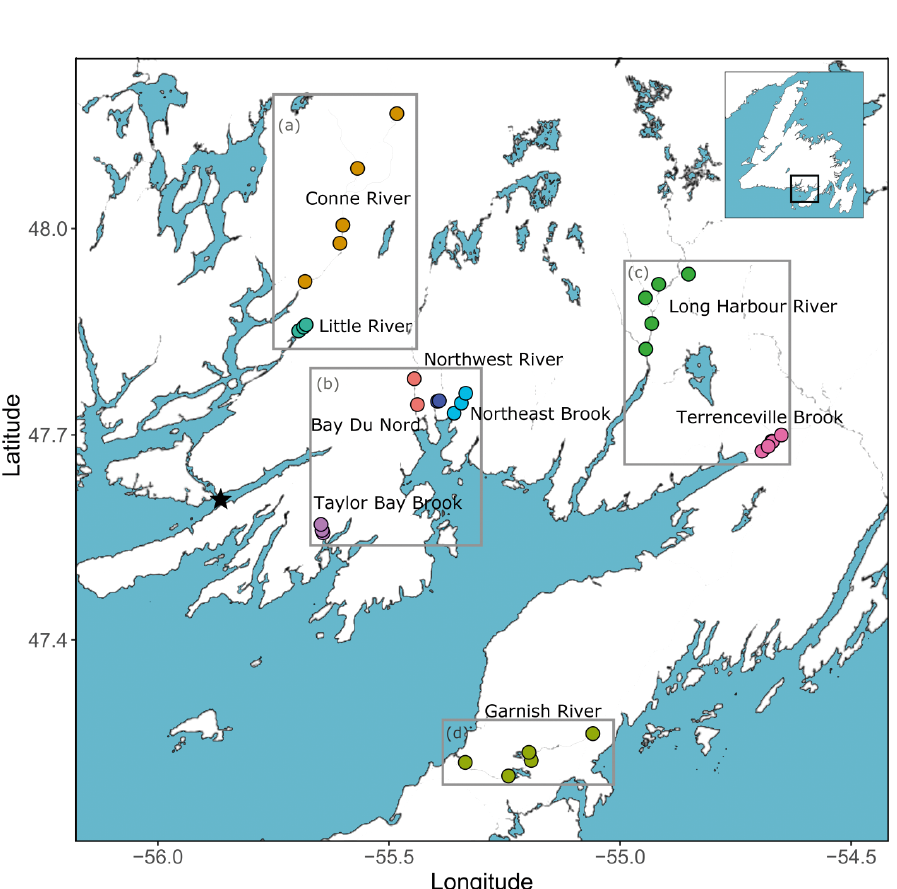
Fig. 1. Sampling sites of Atlantic salmon across 9 rivers in southern Newfoundland, Canada. Sampling sites within a given river are indicated by the same colour. Black star: location of the 2013 aquaculture escape event. Labelled panels correspond to panels of group proportions in Fig.